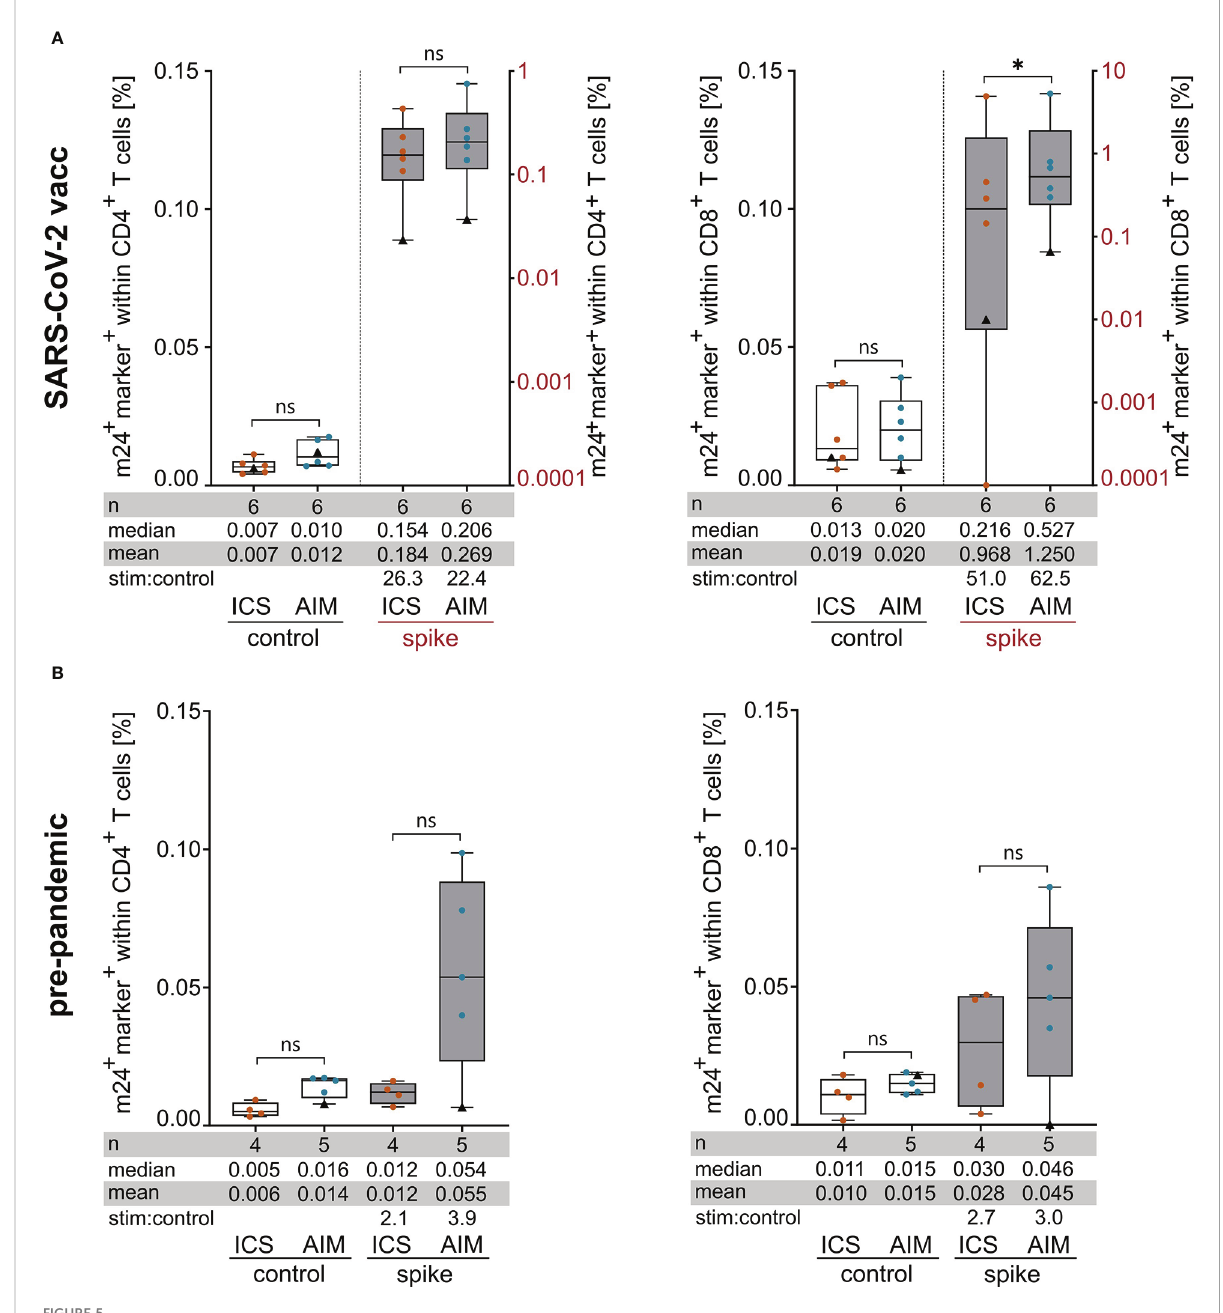
FIGURE 5 Assessment of spike-speci fi c T cell responses with m24+ICS and m24+AIM in SARS-CoV-2 vaccinated (A) and pre-pandemic (B) healthy donors. PBMCs were incubated with SARS-CoV-2/S overlapping peptides or left unstimulated for 14 h in the presence of CD40 Ab (m24+AIM) or brefeldin A and monensin (m24+ICS). Summed frequencies of m24 + and at least one additional marker + T cells after Boolean gating are presented as box and whisker plots showing median, interquartile range, minimum and maximum for CD4 + (left graphs) and CD8 + (right graphs) T cells. Number of donors (n), median, mean and stimulated:control ratios (stim:control) are indicated. For donor HD7 (black triangle), pre- pandemic and post-vaccination samples are shown. Frequencies of stimulated samples are background subtracted. (A) T cell responses in SARS-CoV-2 vaccinated donors (n=6 HD). Frequencies of marker + cells in unstimulated controls (left y-axis) and after spike-peptide stimulation (right y-axis) are plotted for CD4 + and CD8 + T cells. This dataset is also part of Figures 1, 3 and 4. Values that were 0 were set to 0.0001. (B) Frequencies of marker + cells in pre-pandemic PBMCs tested with m24+AIM (n=5 HD) and m24+ICS (n=4 HD, donor HD7 symbolized by a black triangle was tested only with m24+AIM). p<0.05 (* 0.03). ns, not signi fi